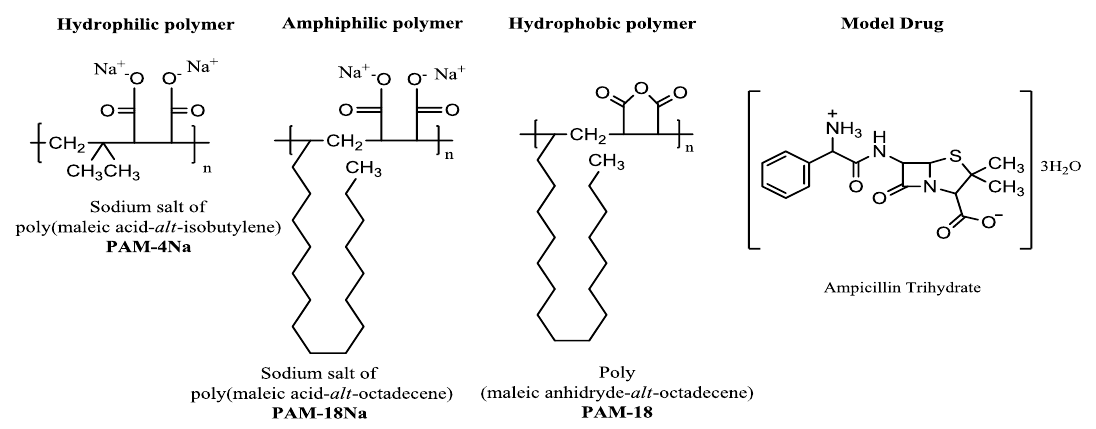
Figure 1. Chemical structure of the monomer units of polymers derived from maleic anhydride and ampicillin trihydrate, corresponding to the materials used in the study.